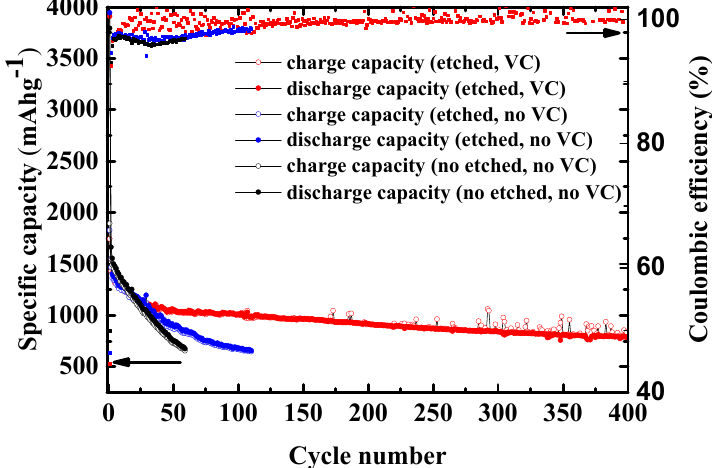
Figure 8. Influence of the HF etching and of VC addition onto the long cycling performance of the Si/MC electrodes. Potential range: 1–0.005 V vs. Li/Li + at C/10.